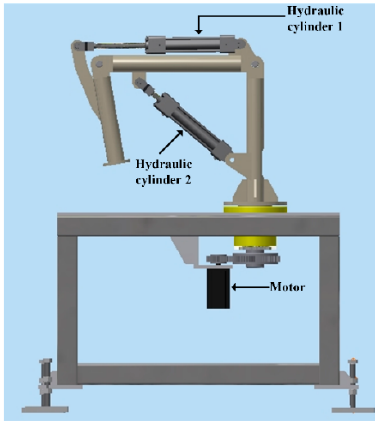
Figure 1. Schematic diagram of the hydraulic manipulator.